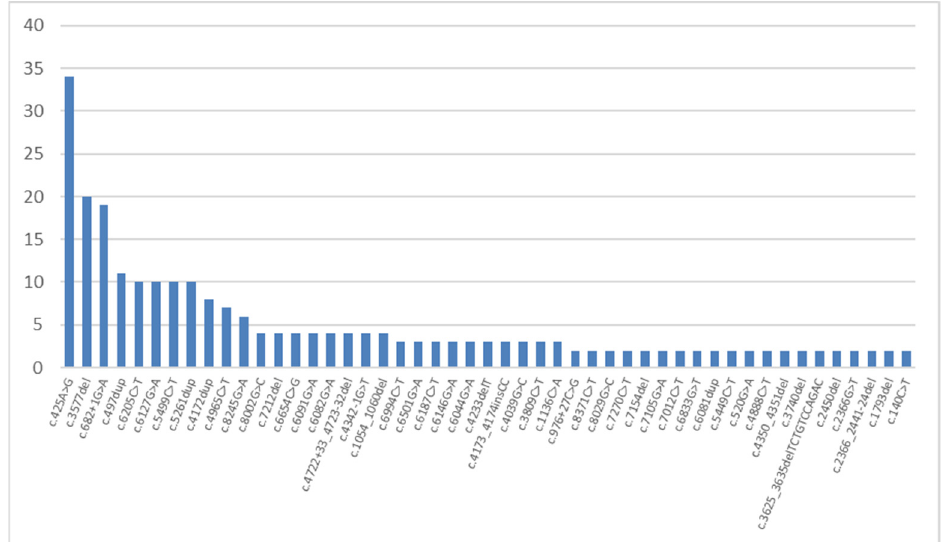
Figure 3. The frequencies and spectrum of COL7A1 gene mutations detected more than twice in Russian children with dystrophic EB.